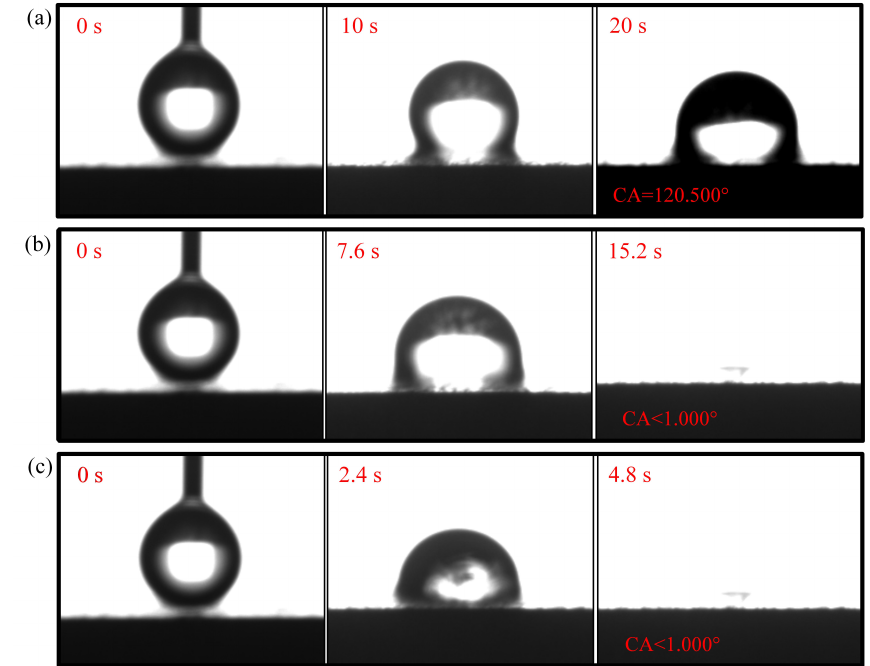
Figure 8. Wettability test of 5-CCC: ( a ) α region; ( b ) β region; ( c ) γ region.